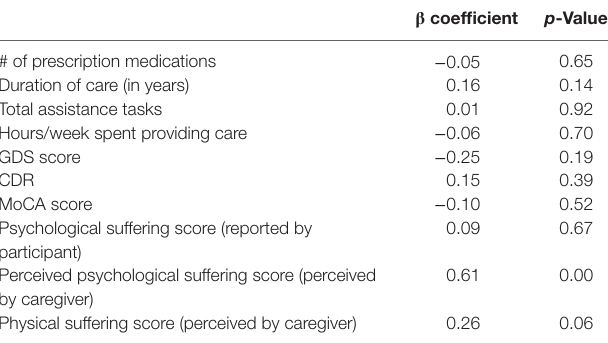
TaBle 5 | Linear regression model predicting ZBI-12.